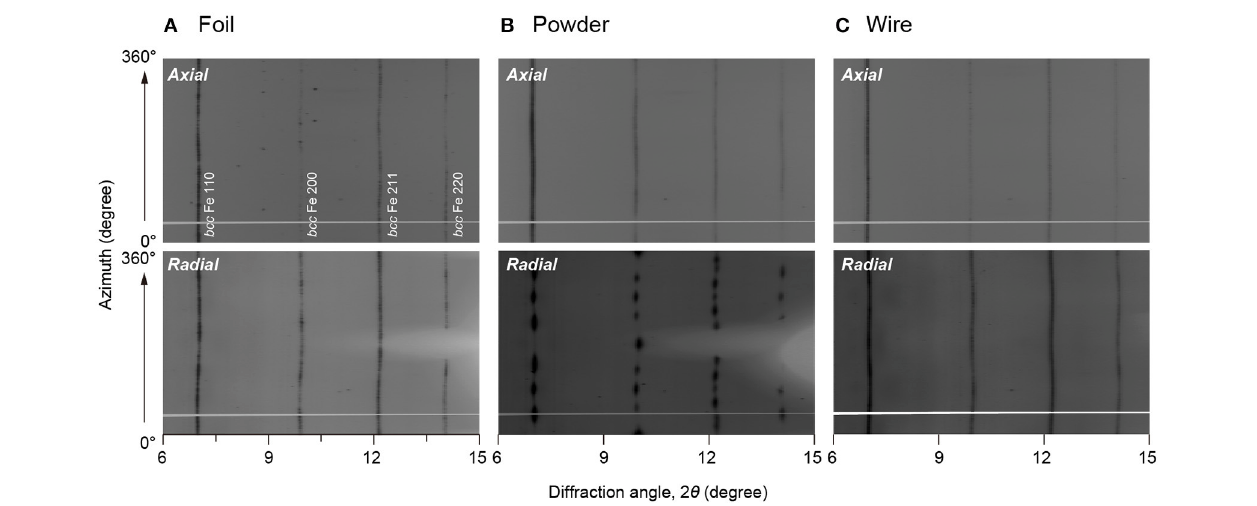
FIGURE 4 | Unrolled XRD images of iron starting materials, (A) foil, (B) sintered powder, and (C) wire obtained at 1 bar. Upper panels show XRD images obtained from the axial geometry, and lower panels are the radial XRD images. Miller indices of bcc iron are shown in the upper left panel. Horizontal gray line in each image is a shadow of beam stopper holder. Wavelength of incident X-ray was 0.247